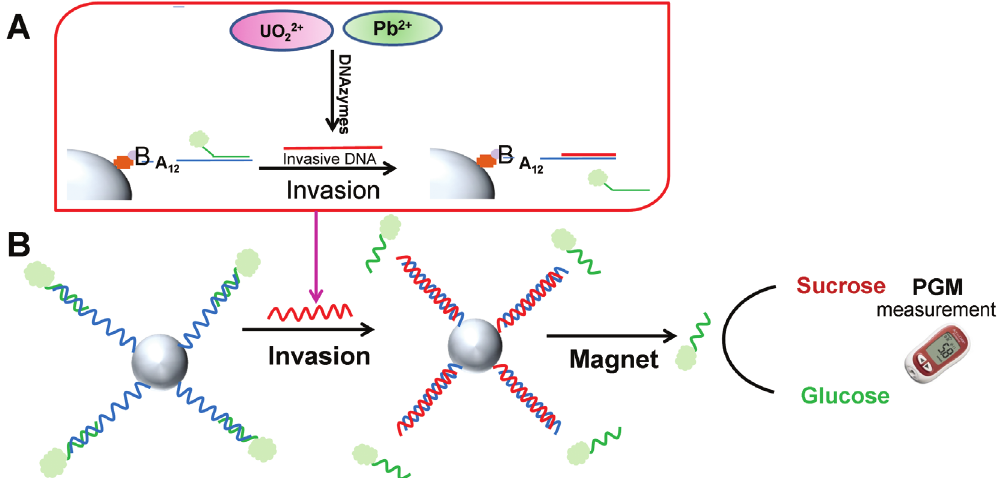
Figure 6 (A) Pb 2+ -induced and UO 22+ -induced cleavage of the DNA substrates by the corresponding DNAzyme. Both reactions yield the cleaved ssDNA product (red) as invasive DNA and release of DNA-invertase conjugates from MBs by the invasive DNA. (B) The invasion and release steps, followed by the conversion of sucrose into glucose by the released DNA-invertase conjugates for PGM measurement. Reprinted with permission from: Xiang and Lu 2013. Copyright 2013, Royal Society of